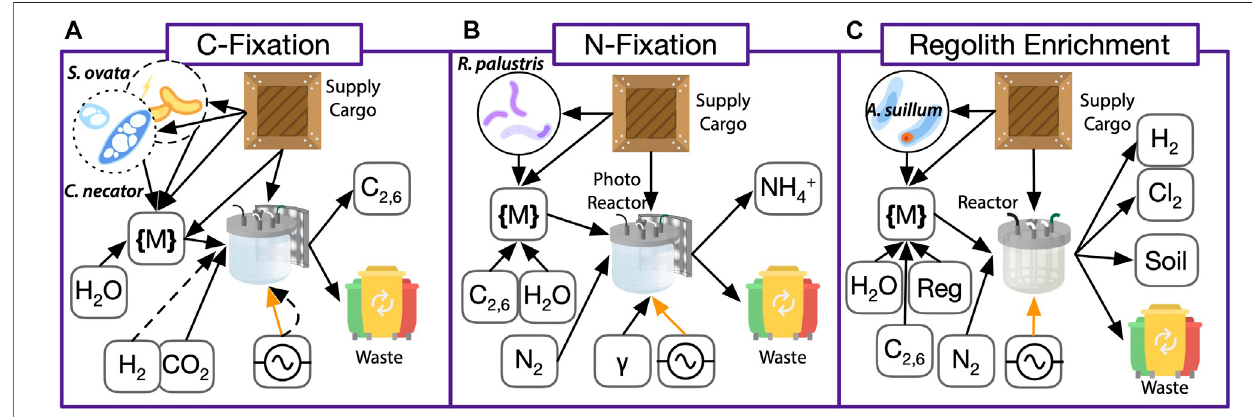
FIGURE 5 | ISRU (purple in Figure 2 ) system breakdown of biomanufactory elements. (A) Carbon fi xation with the autotrophic bacteria Sporomusa ovata or Cupriavidus necator through electrosynthesis or lithoautotrophic fi xation of C 1 -carbon (cathodes or H 2 as the electron donor). (B) Microbial nitrogen fi xation with diazotrophicbacterialike Rhodopseudomonaspalustris growingphotoheterotrophically (C) Regolith(Reg)enrichmentusingtheperchlorate-reducingmicrobe Azospira suillum . Black lines represent material and energy fl ows related to biological consumption and production. Orange lines indicate additional power supply to the